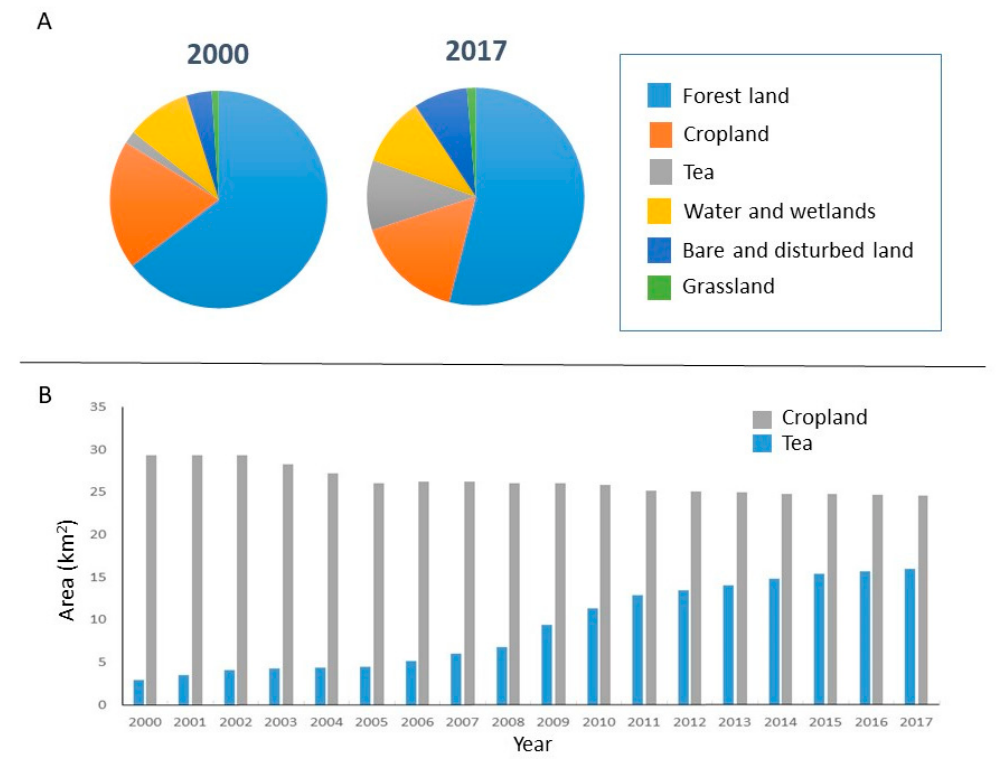
Figure 5. Changes in land cover / land use in the Tianmu Lake watershed between 2000 and 2017. ( A ) Land cover / land use in the years 2000 and 2017. The category bare and disturbed land includes construction land, and in 2017, land removed from crop production and returned to its natural state. ( B ) Year by year changes in the area devoted to cropland and tea production.